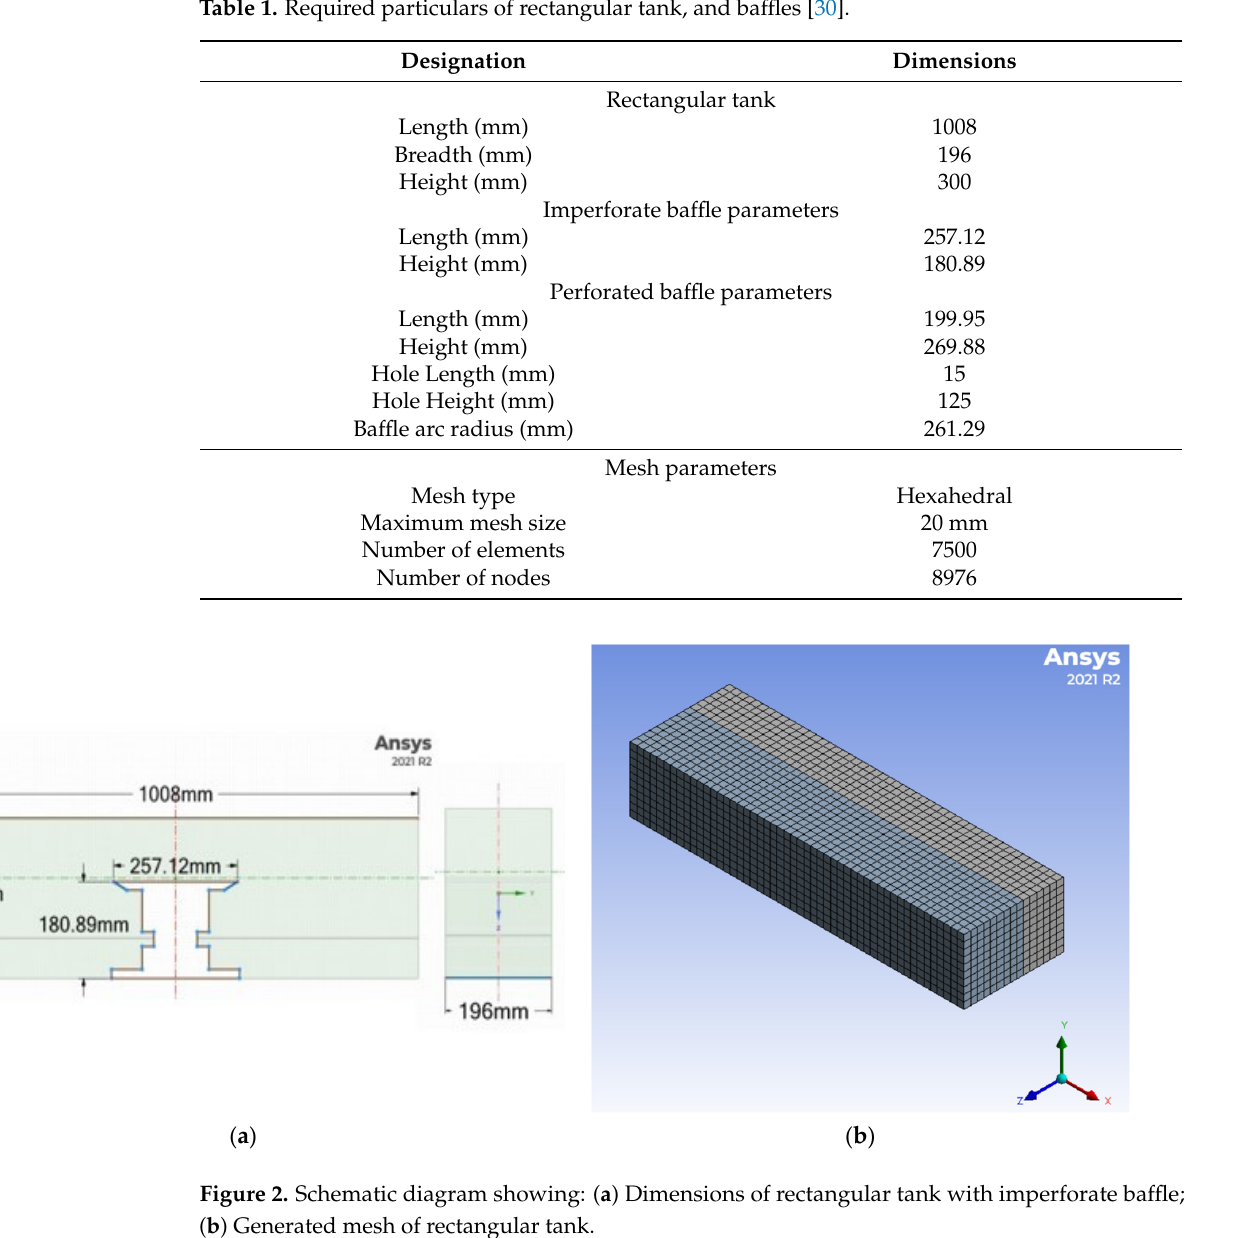
( b ) Figure 3. Schematic diagram showing: ( a ) dimensions of perforated baffle; ( b ) isometric view of rectangular tank with perforated baffle in ANSYS SpaceClaim.